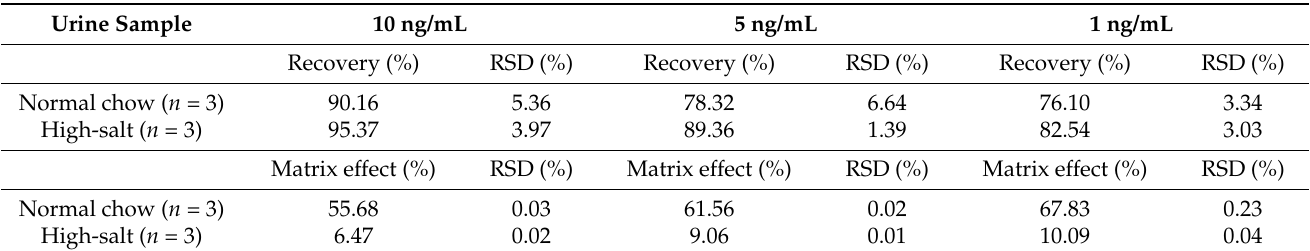
Table 1. Calculation of DIG recovery and matrix effects from normal chow urine